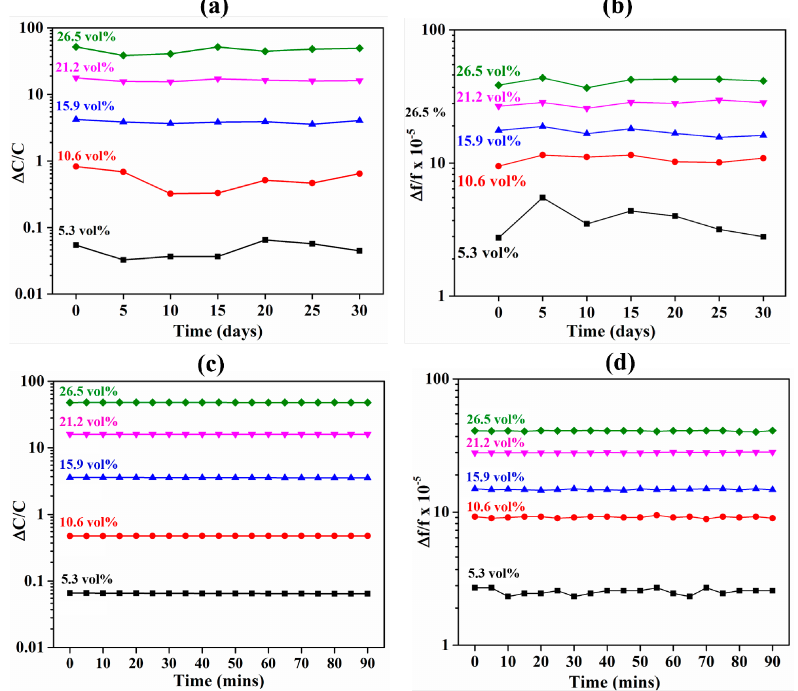
Figure 7. Stability analysis of the ZIF-8-coated sensors to acetone gas. ( a ) Shows the long-term stability of the capacitive sensor for 30 days. ( b ) Shows the long-term stability of the QCM-based sensor for 30 days. ( c ) Shows the short-term stability of the capacitive sensor. ( d ) Shows the short-term stability of the QCM-based sensor.